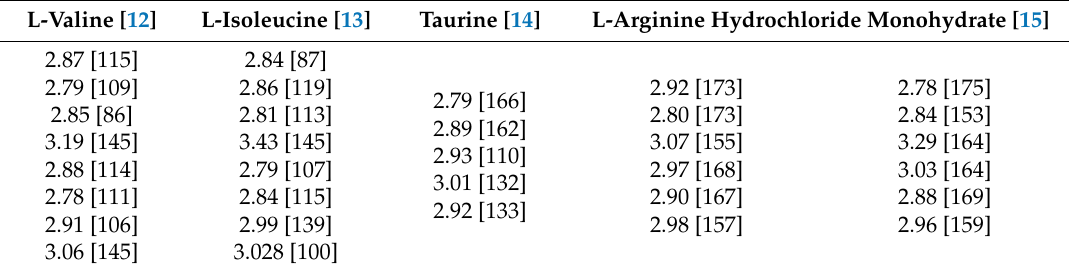
Table 2. Comparison of geometric parameters of the hydrogen bonds (HBs) for four di ff erent